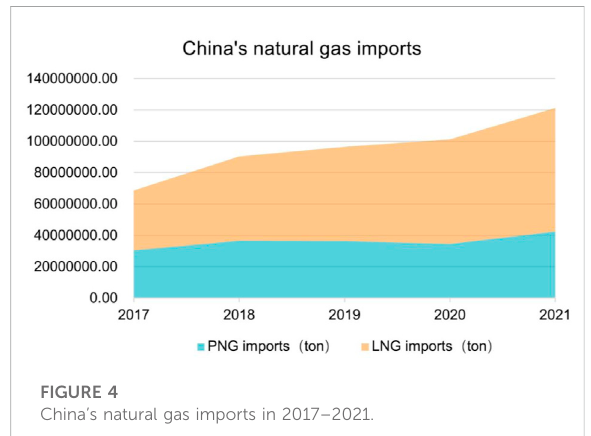
FIGURE 3 Natural gas production, consumption and imports in China.